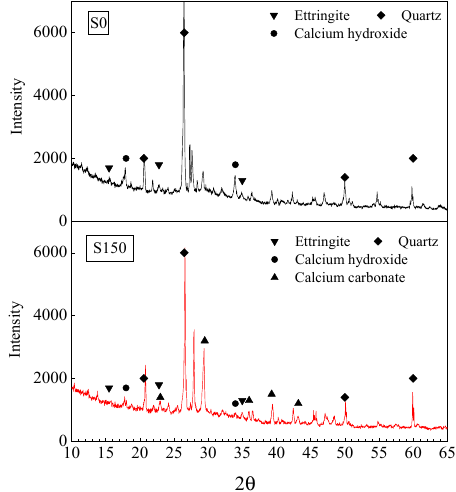
Figure 10. XRD patterns of RAC in control condition (S0) and subjected to sulfate-exposed FT cycles (S150).